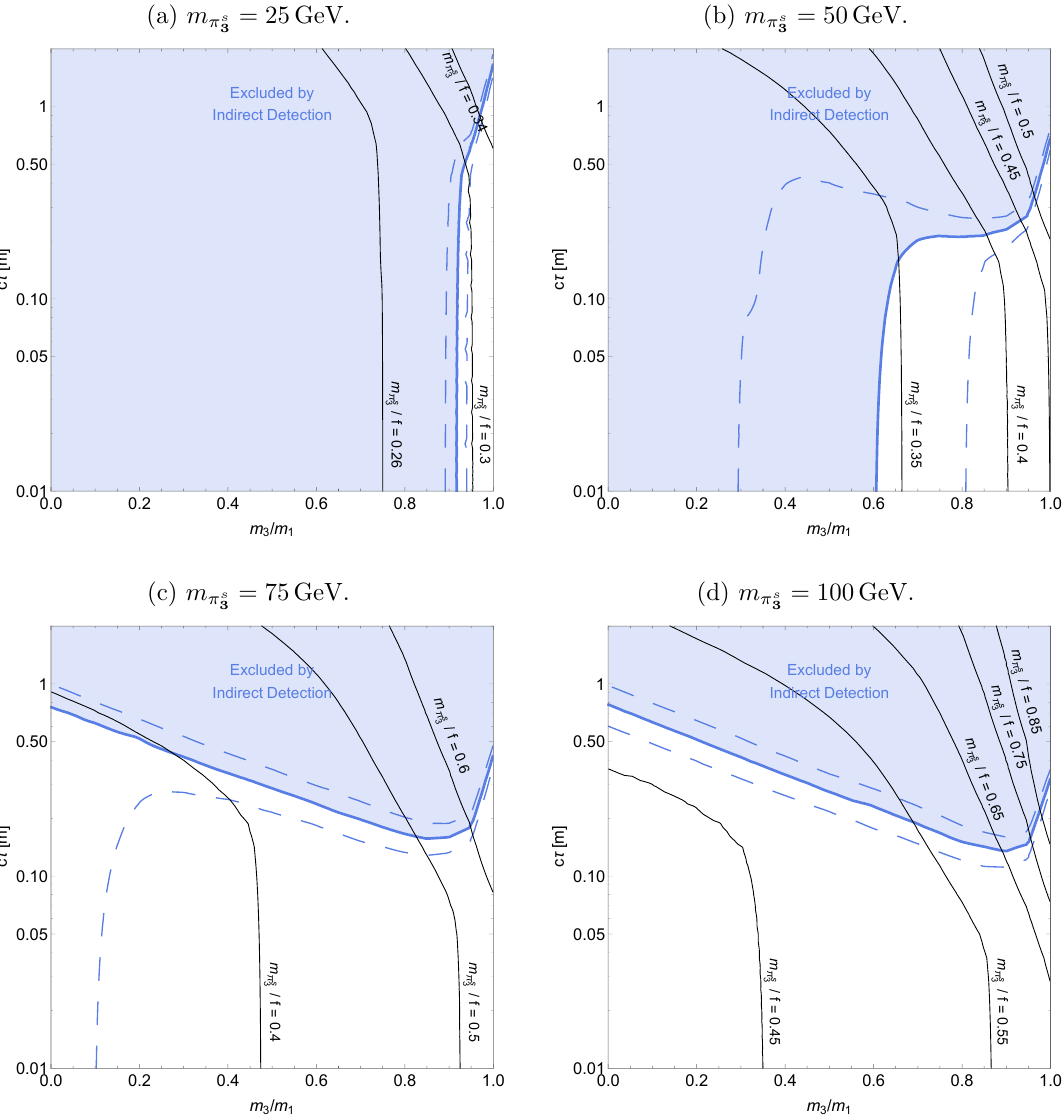
Figure 3. Allowed region of parameter space for the benchmark CIa for di(cid:11)erent masses of the triplet. The black contour lines represent constant values of m (cid:25) s =f . The blue region is excluded by 3 indirect detection dark matter searches. The dashed blue lines correspond to what the exclusion limit would be if the limit on the indirect detection e(cid:11)ective cross section were to vary by (cid:6) 10%.